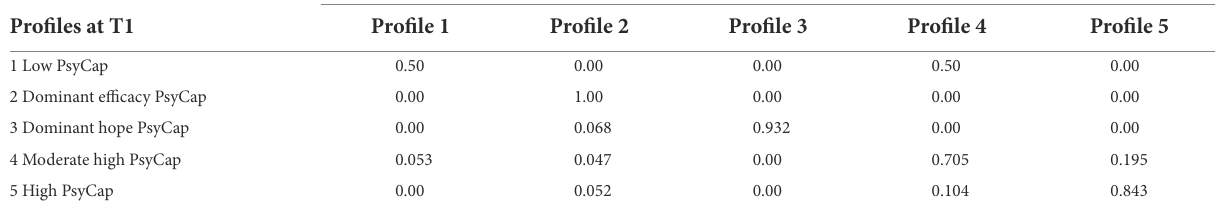
TABLE 4 Profile transition probabilities.